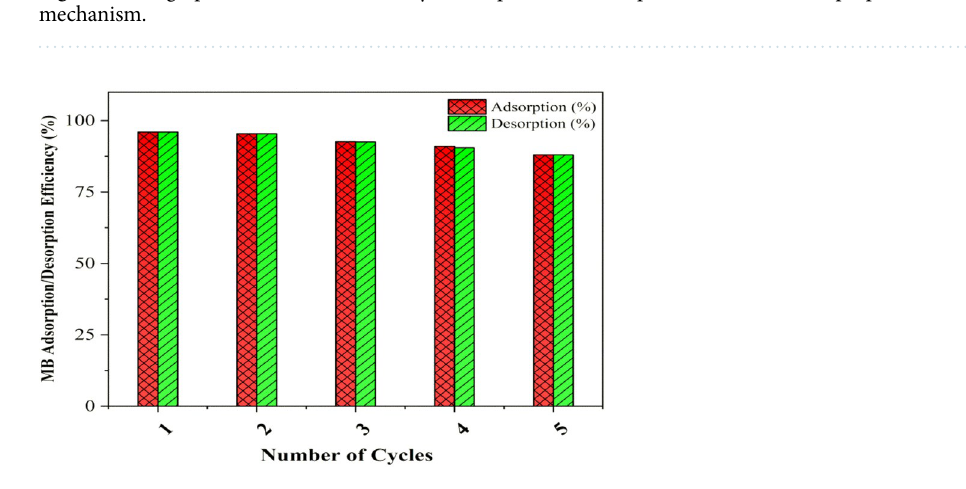
Figure 16. Adsorption–Desorption efficiency of MB onto (OSMG) adsorbent after 5